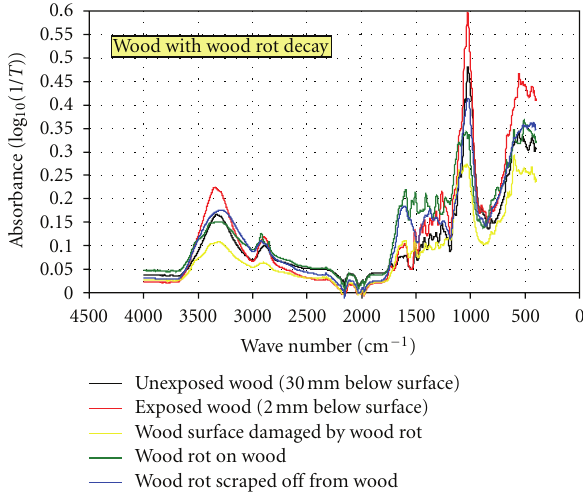
Figure 2: Absorbance (logarithmic) versus wave number between 4000–400 cm − 1 for mould fungi at various exposure levels on GU plaster board. ( T : transmittance).